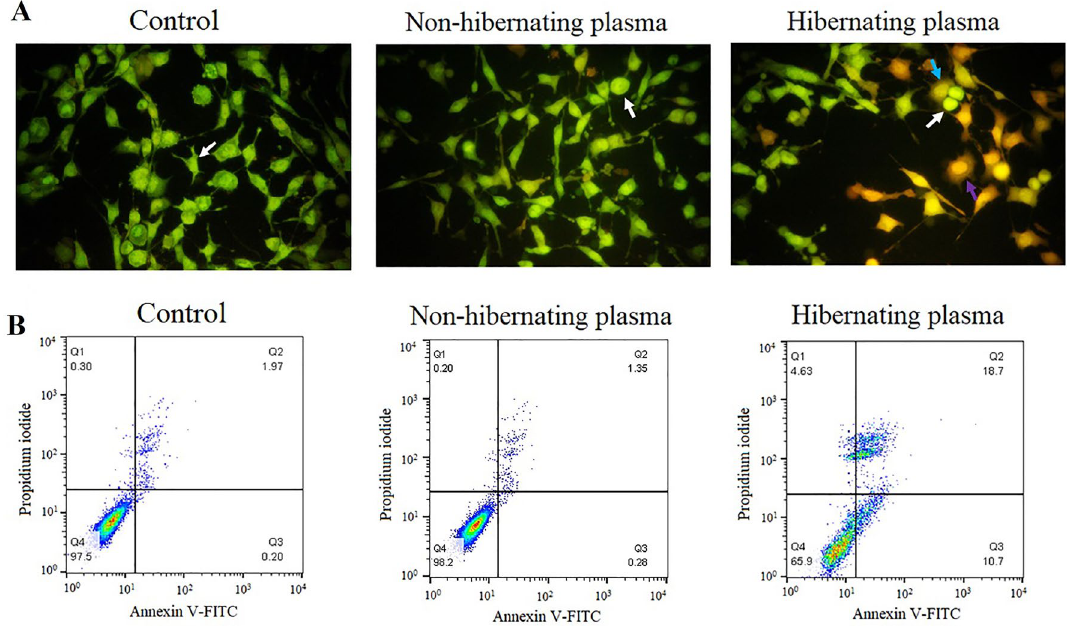
Figure 3. Evaluation of the ability to induce apoptosis in cancer cells by hibernating plasma according to the AO/EB double staining using a fluorescent microscope and the Annexin V-FITC/PI staining using flow cytometry. ( A ) The AO/EB double-stained 4T1 cancer cells after 24 h incubation with non-hibernating plasma (16 mg/ml) and hibernating plasma (16 mg/ml) under a fluorescent microscope (Magnification × 200). The control cells were incubated with standard culture media. Viable cells are stained uniformly pale-green (white arrow); Early apoptotic cells are stained bright-green to yellow (blue arrow); Late apoptotic cells are stained yellow-orange or red color (purple arrow); Necrotic cells can be detected as bright orange-red cells. ( B ) Quantification of hibernating plasma (16 mg/ml for 24 h) - induced apoptosis in 4T1 breast cancer cells by the Annexin V-FITC/PI staining using flow cytometry in comparison with non-hibernating (16 mg/ml for 24 h) and control. In each four-quadrant diagram, the lower left quadrant (Q4), lower right quadrant (Q3), upper right quadrant (Q2), and upper left quadrant (Q1) represent viable, early apoptotic, late apoptotic, and necrotic cells, respectively.